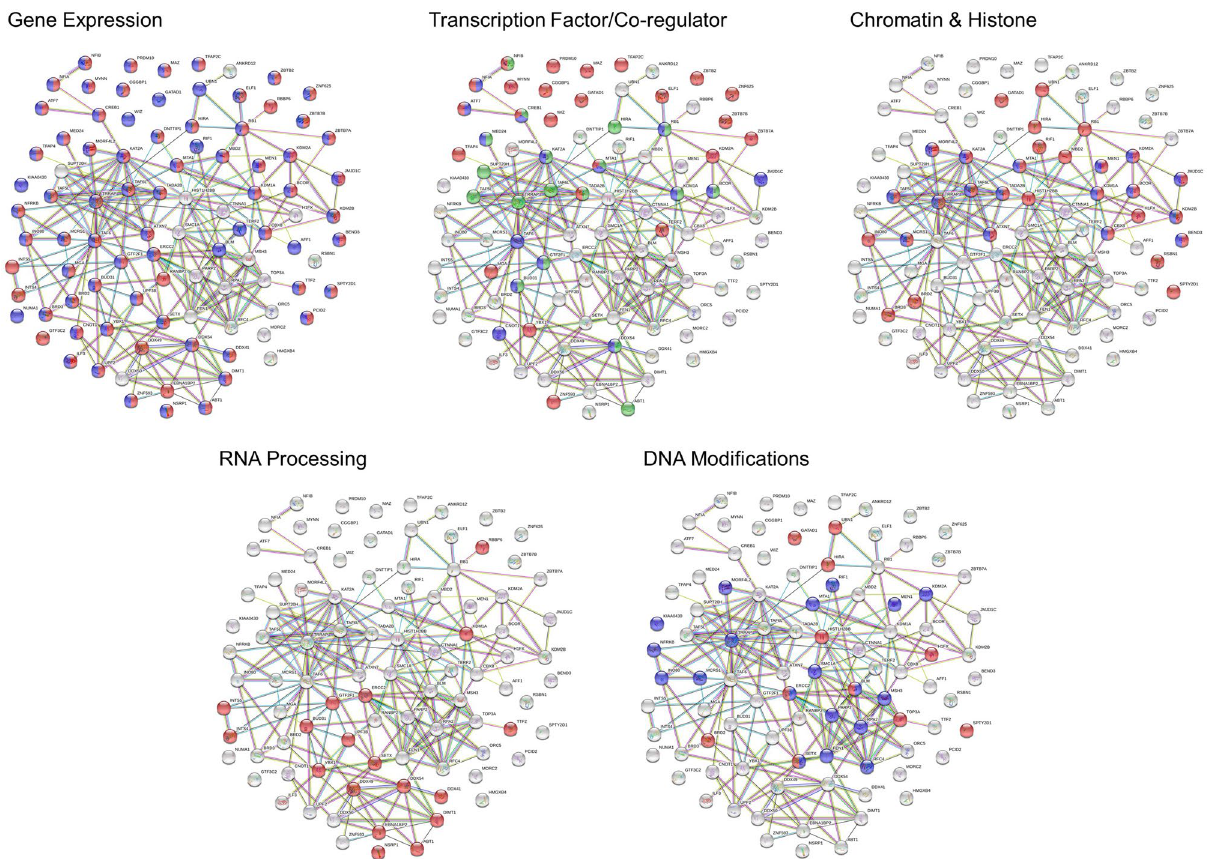
Figure 4. GO term enrichment analyses of proteins associated with Segment A as the core CXXC5 promoter element using the STRING interaction database. Nuclear extracts of MCF7 cells were incubated overnight with a 5 ′ -end biotinylated PCR amplicon containing Segment A or a fragment of Exon10 as the control followed by precipitation with streptavidin-conjugated magnetic beads. Bound proteins were then subjected to MS for protein IDs. Proteins are grouped under the headings of Gene Expression [GO: 0010467 Regulation of gene expression (red) and GO: 0010468, Gene expression (Blue)]; Transcription Factor/co-Regulator [GO: 0000981, DNA-binding transcription factor activity (red), GO:0008134, Transcription factor binding (blue), and GO: 0003712, Transcription co-regulator activity (green)]; Chromatin and Histone [GO: 0006325, Chromatin organization (red) and GO: 0016570, Histone modification (blue)]; RNA Processing [GO: 0006396, RNA processing (red)]; and DNA Modifications [GO: 0006281, DNA repair (red) and GO: 0071103, Conformational changes